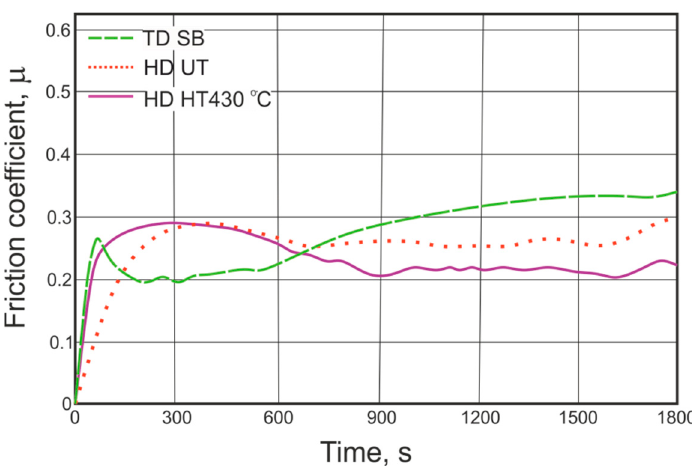
Figure 10. The comparison of the friction coefficient values registered during testing of the TDSB and HDUT, HDHT coatings.